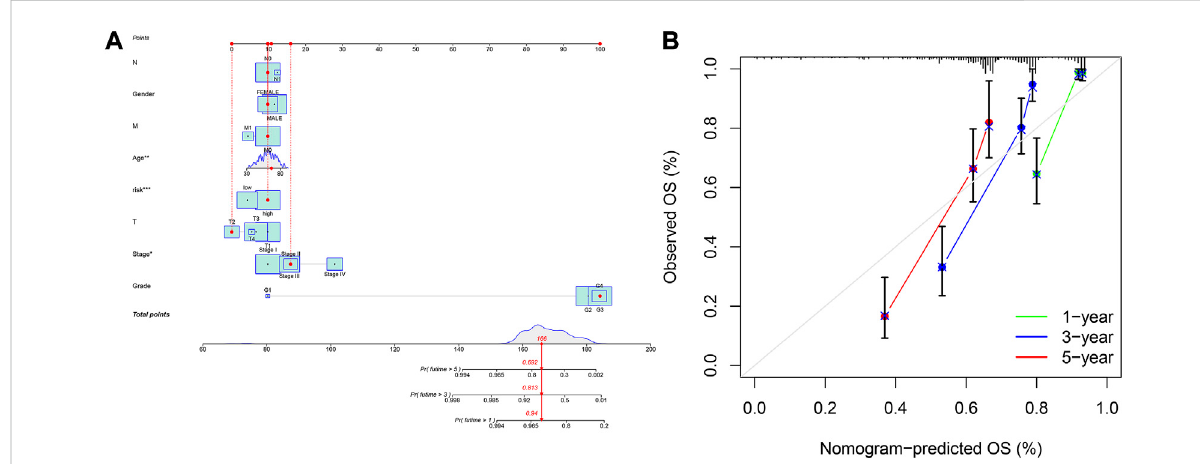
FIGURE 8 Construction of nomogram based on the signature and clinicopathologicalfactors. (A) nomogramfor predicting 1-, 3-, and 5-year OS. (B) The calibration plots for predicting 1-, 3-, and 5-year